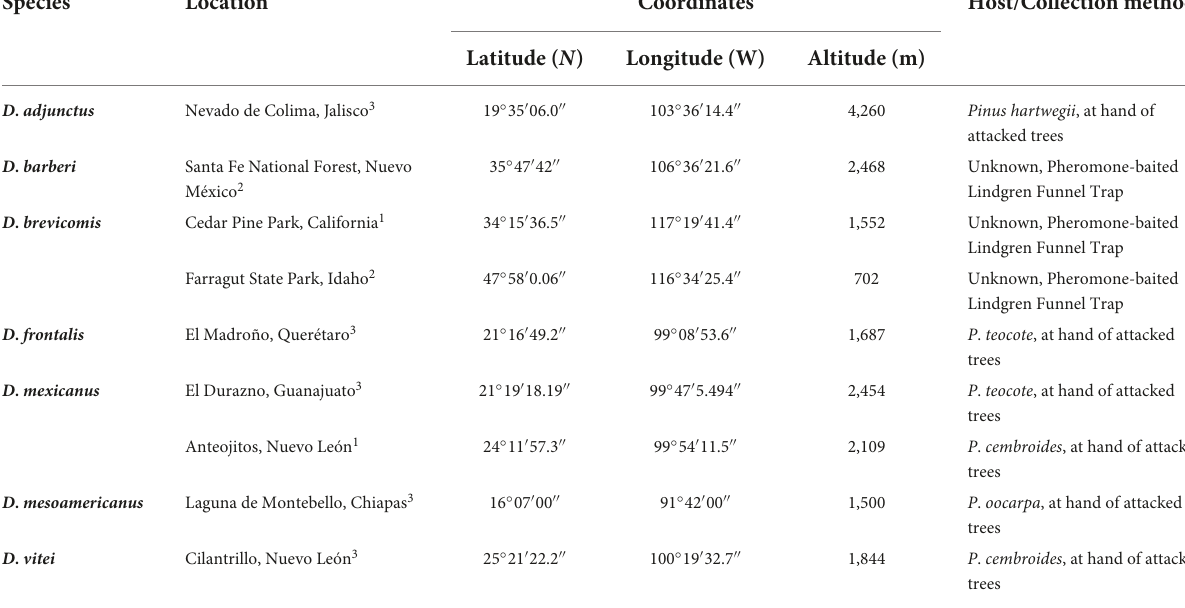
TABLE 1 Collection sites from the species of the Dendroctonus frontalis complex.